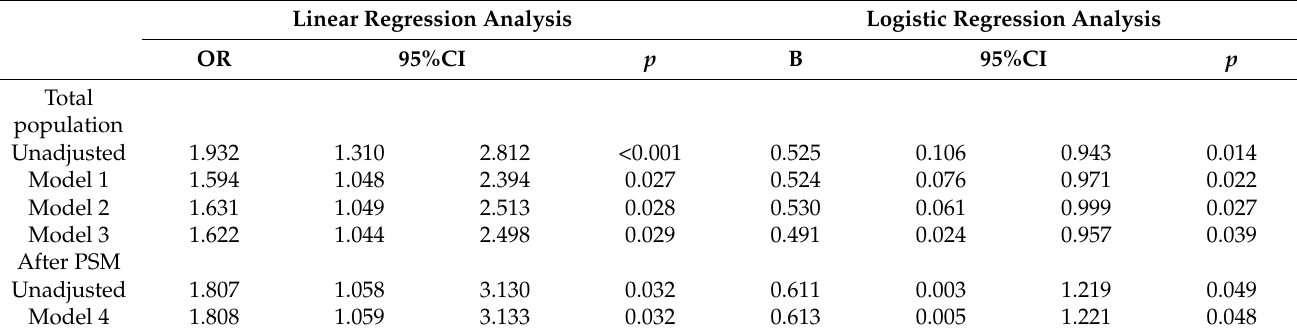
Table 6. Sensitivity analysis of relationship between PP and cognitive decline. Linear Regression